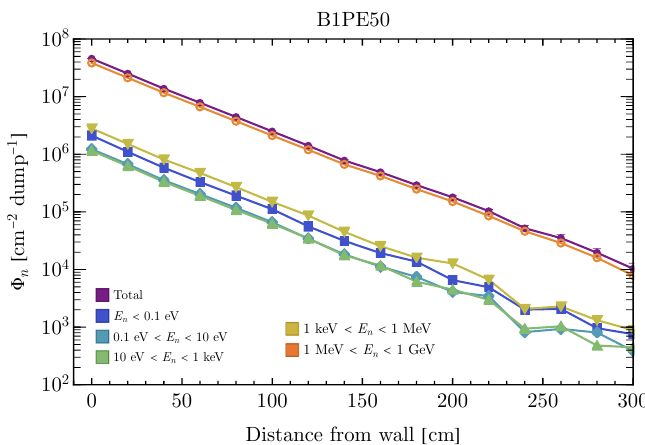
Figure 5. Neutron flux for several ranges of neutron kinetic energy as a function of the distance from wall of the toy dump station setup (see text for